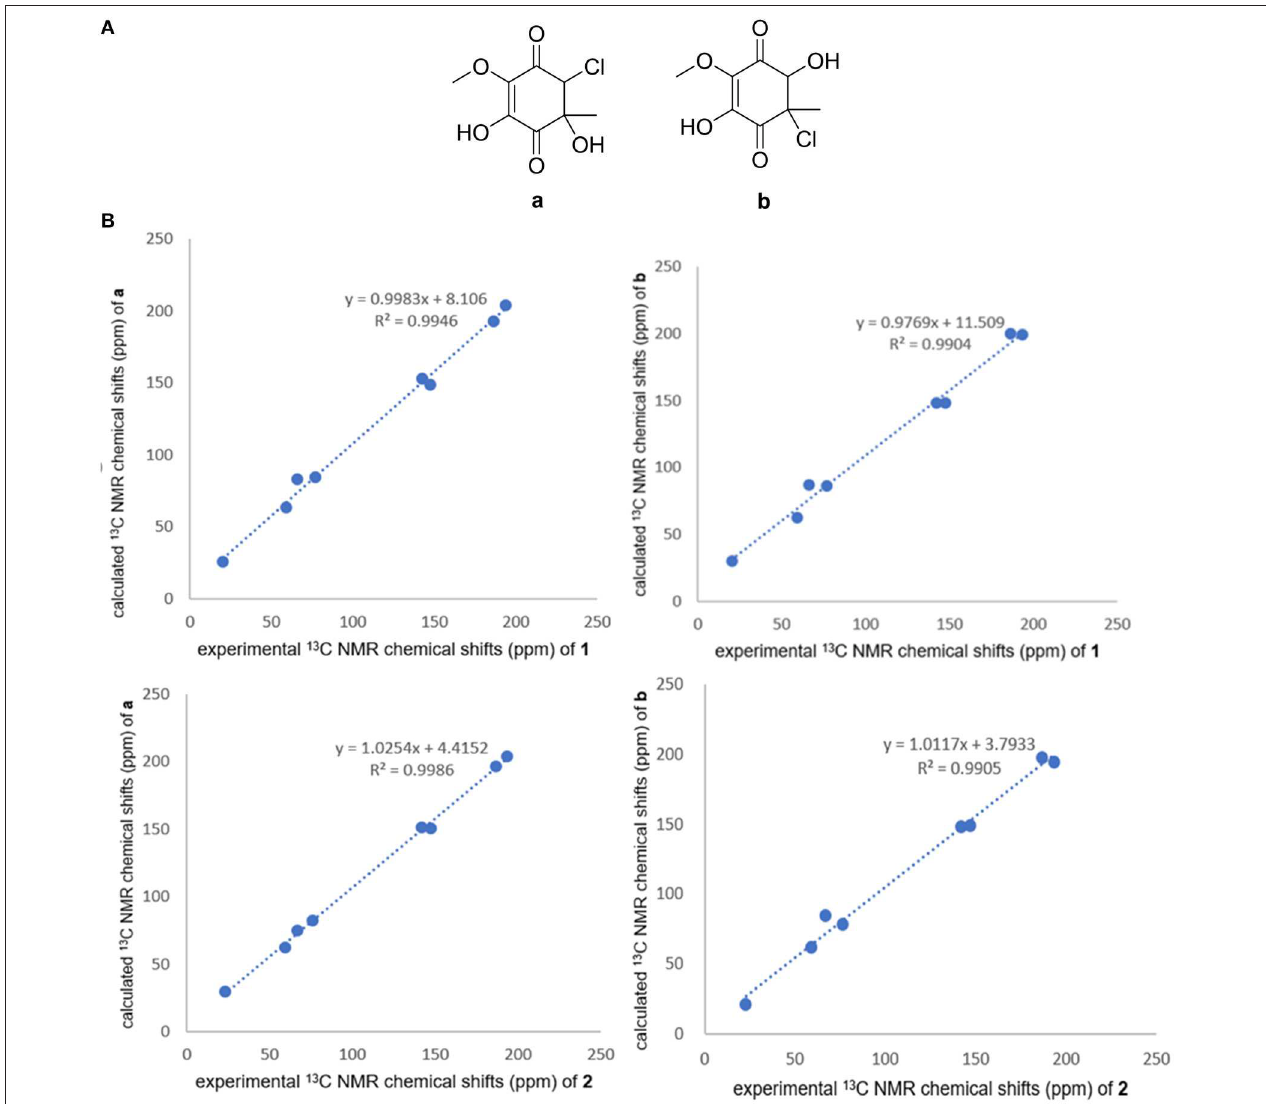
FIGURE 3 | (A) Structures of a and b . (B) Correlation plots of experimental 13 C NMR chemical shifts of 1 and 2 versus the corresponding calculated data for the proposed structures a and b .